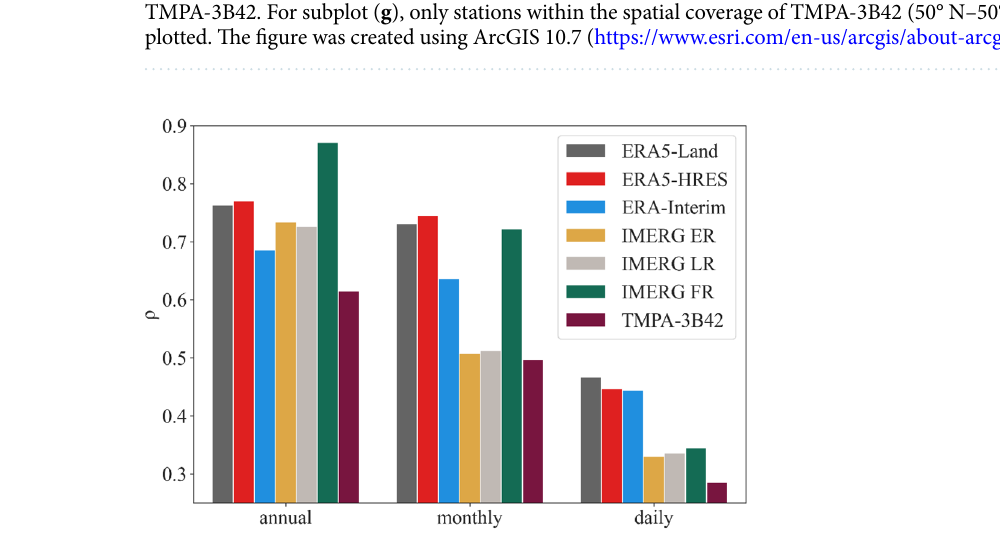
Figure 5. Average spatial Spearman correlation coefficients for each product at different temporal